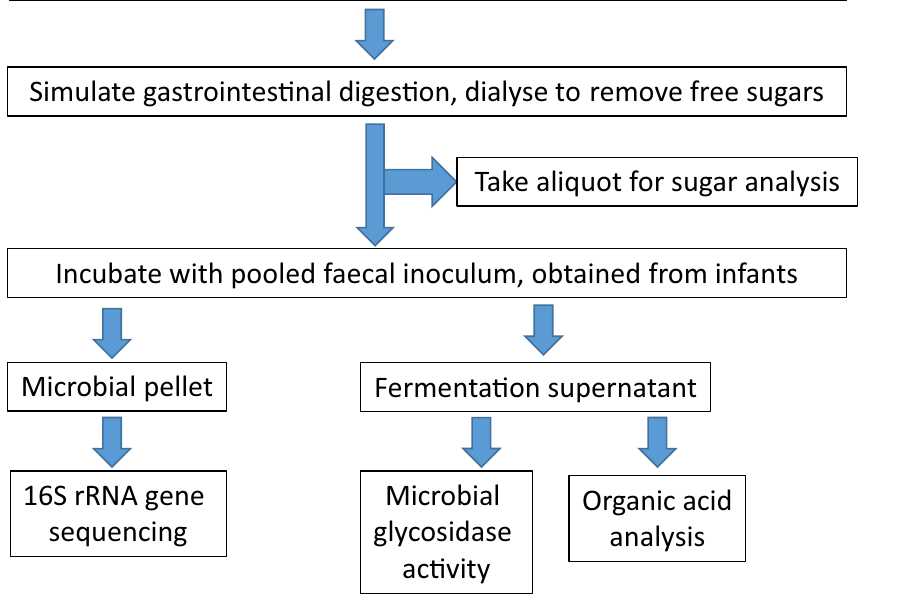
Figure 1. Workflow of the experimental protocol and analyses.